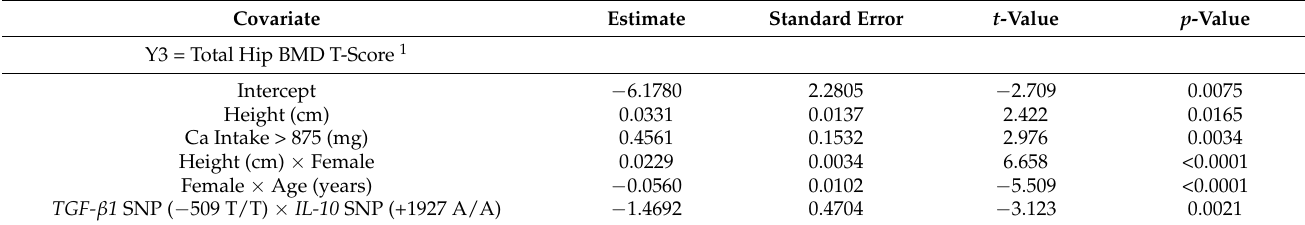
Table 5. Multivariate analyses of the predictors of total hip BMD T-scores using MLR models.